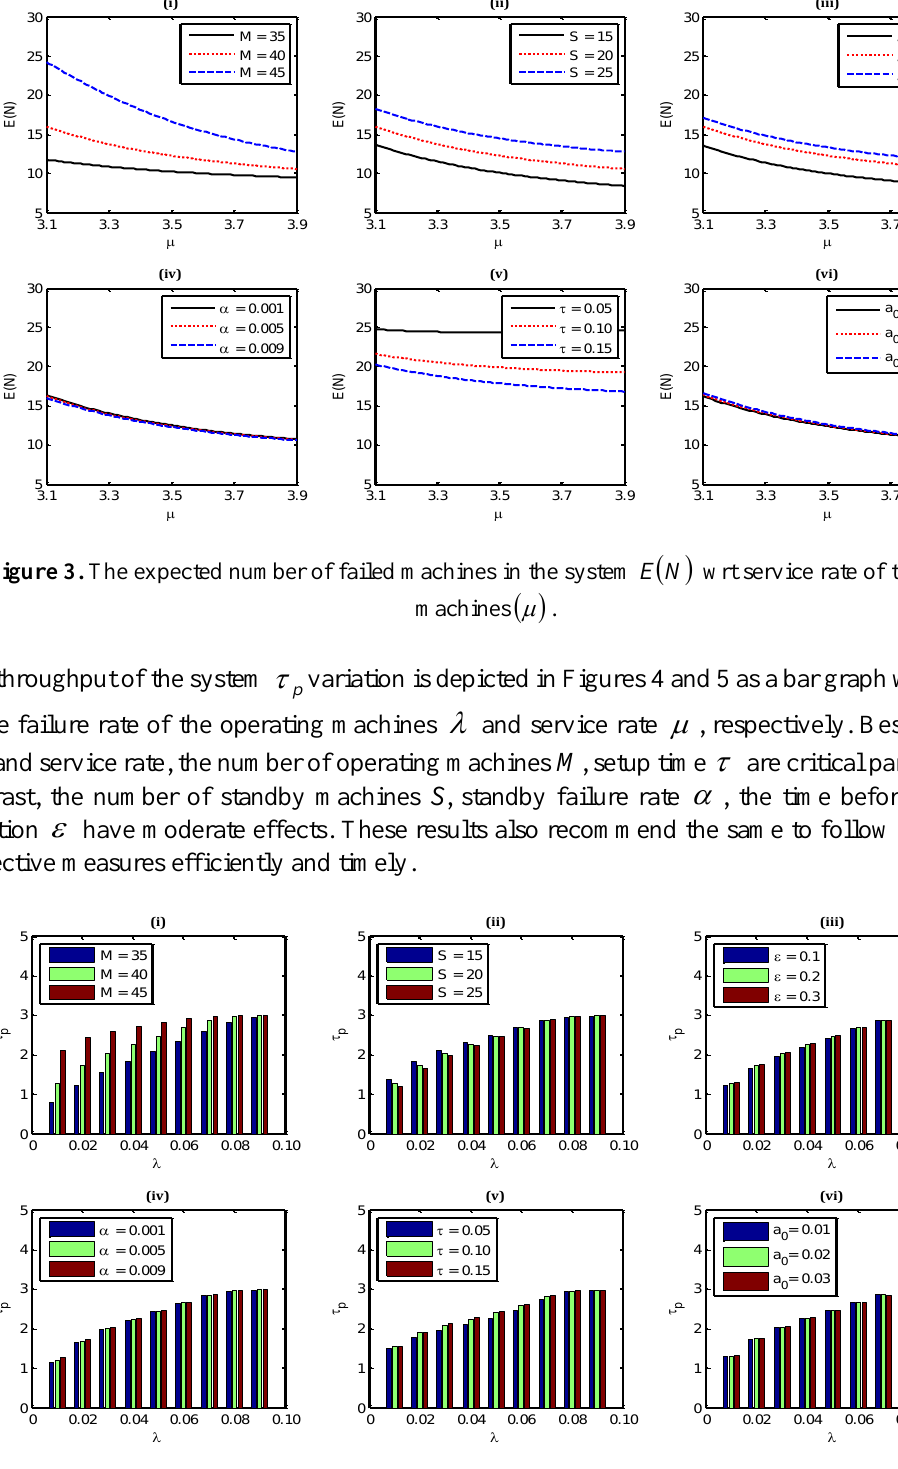
Figure 4. The throughput of the system